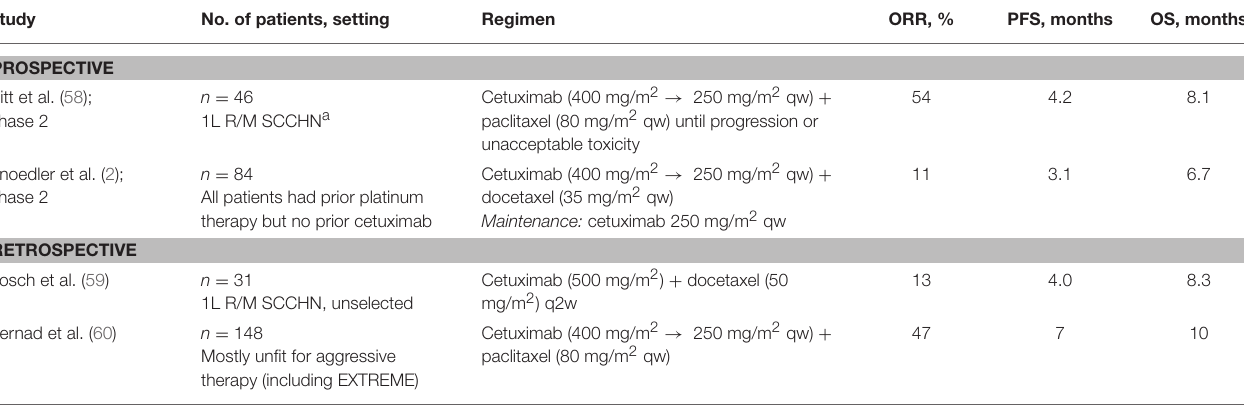
TABLE 4 | Studies of cetuximab + taxane–only regimens. Study No. of patients,